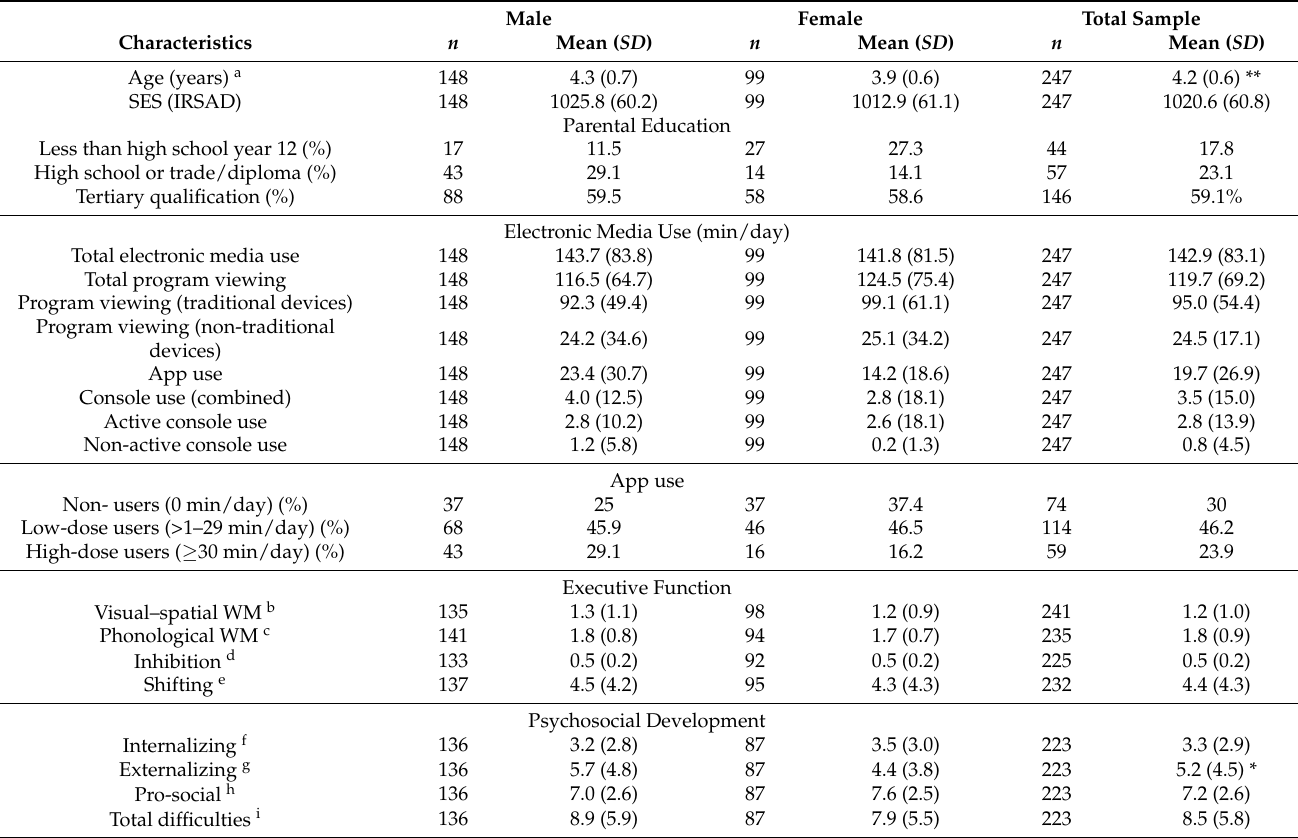
Table 1. Participant